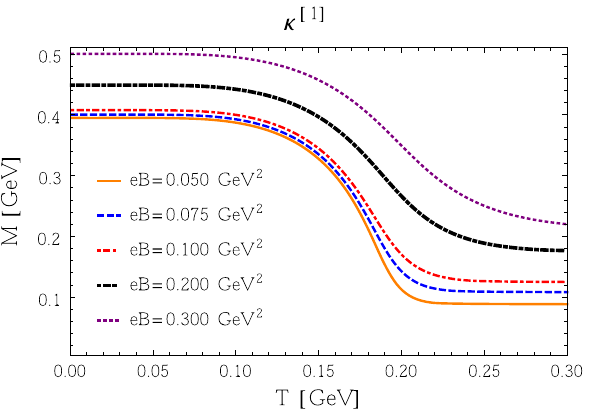
Fig. 1 Effective quark mass as a function of the temperature for dif- ferent values of fixed magnetic field strength. For these results, it was adopted the set κ [ 1 ]